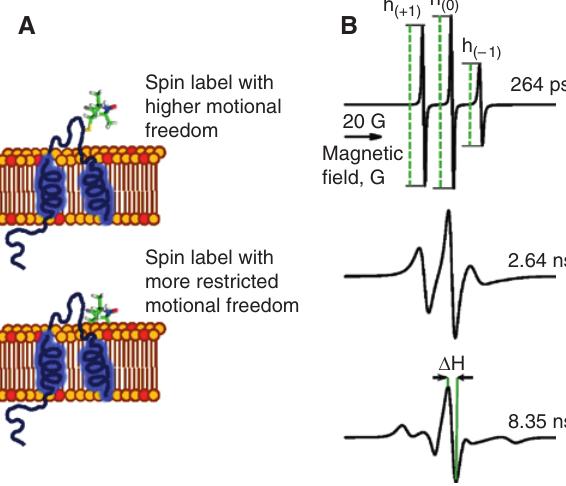
Figure 3: The spin label dynamics and local environment can be monitored by changes in the cw-EPR lineshape. (A) Spin labels intro- duced in a protein loop regions that are far from the lipid bilayer have higher motional freedom compared to those of spin labels in of contact with membrane. (B) Simulated cw-EPR spectra with τ c 264 ps, 2.64 ns and 8.35 ns are shown. EPR spectra were simulated using the MultiComponent software of C. Altenbach. The peak-to- peak intensities, h , h and h , of the three lines in the nitroxide ( + 1) (0) ( − 1) spectrum are indicated in the upper panel. The width Δ H of the central line in the nitroxide spin label EPR spectrum is shown in the lower panel. All spectra were scaled to a common value at maximum intensity for clarity of